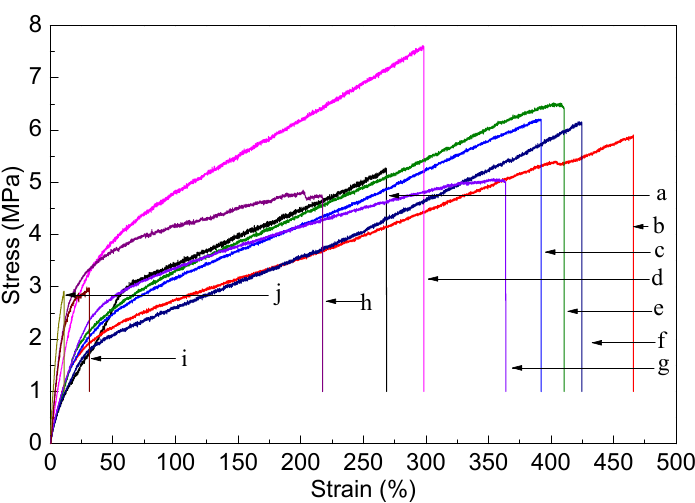
Figure 8. Stress–strain curves of pure TPU film ( a ) and GO-TPU films prepared with loadings of GO of 0.1 wt % ( b ), 0.3 wt % ( c ), 0.6 wt % ( d ), 1 wt % ( e ), 2 wt % ( f ), 3 wt % ( g ), 4 wt % ( h ), 5 wt % ( i ), and 7 wt % ( j ), respectively.